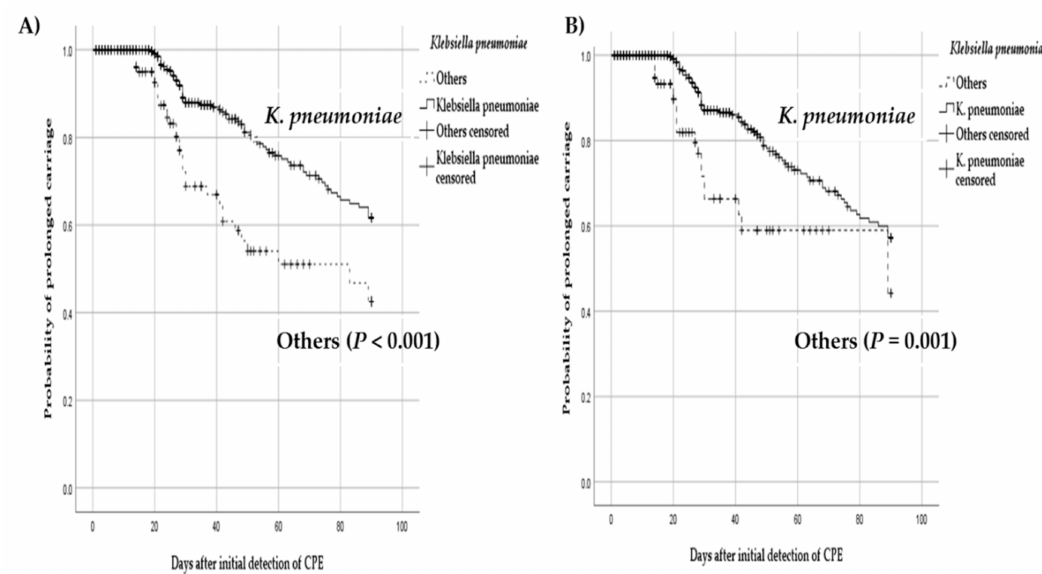
Figure 2. Kaplan–Meier estimates for the cumulative probability of prolonged carriage according to the types of organ- ism. ( A ) K. pneumoniae versus other types of organism including patients with polymicrobial carriage (log-rank test); ( B ) K. pneumoniae versus other types of organism in patients with monomicrobial carriage (log-rank